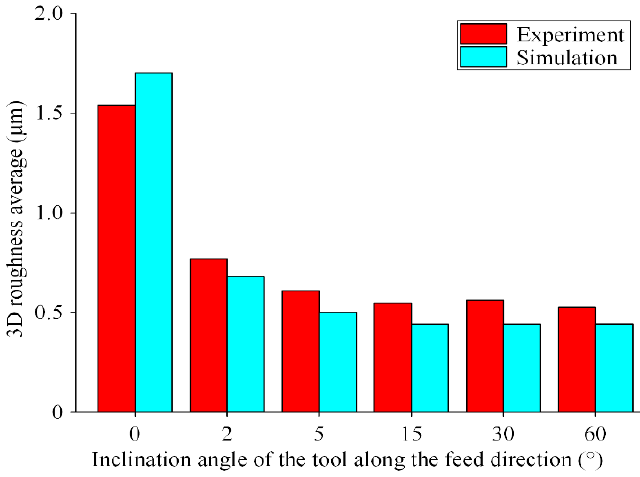
Figure 14. Comparison of surface roughness between experiments and simulations.